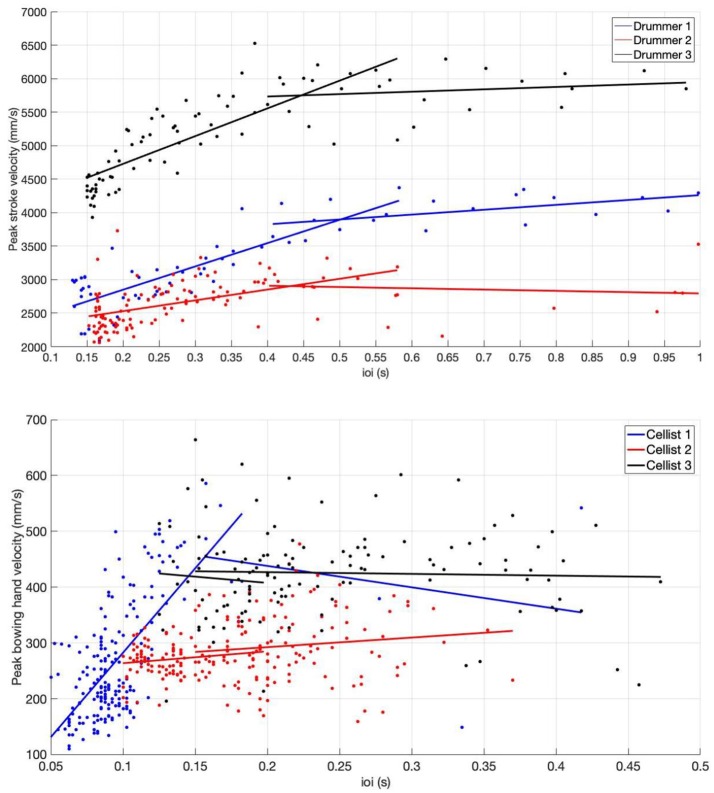
Measured peak velocity vs. inter onset intervals with fitted linear lines to illustrate the playability regions for the drummers (Top) and cellists (Bottom). Note the smaller values in ioi for the cellists due to the separation of up- and down bows in ioi. For drummers D1 and D3 (top), the decrease in peak velocity when accelerating from slow to fast (going from right to left along the ioi-axis) is clearly seen. Player D1 is able to push the limit of “break down” further than the students. For the cellists the different phases are mainly seen for player C1 since students C2 and C3 had difficulty performing at faster tempi.